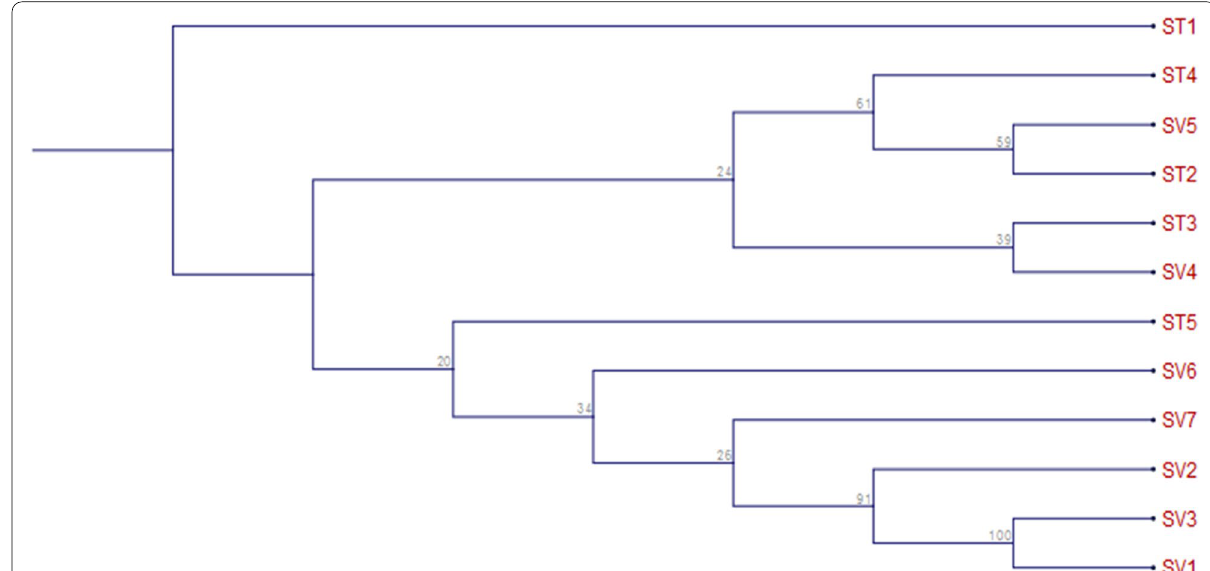
Fig. 5 1000 bootstrap replications of phylogenetic tree of partial matK gene sequences